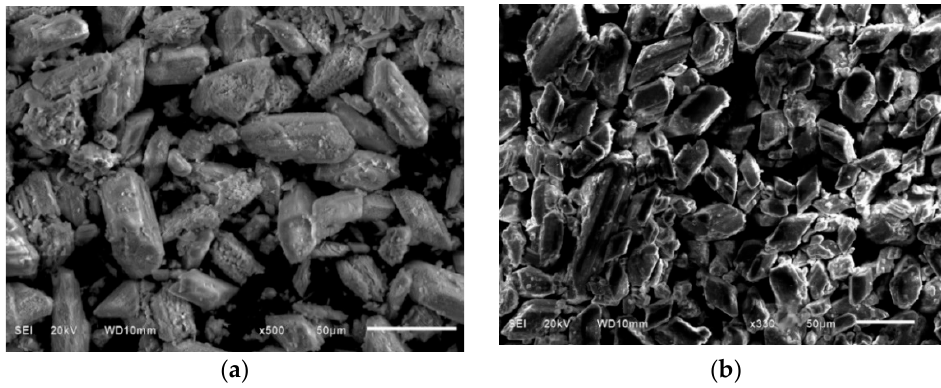
Figure 3. SEM of FGD gypsum. ( a ) Calcined FGD gypsum at 800 °C. ( b ) Raw FGD gypsum.